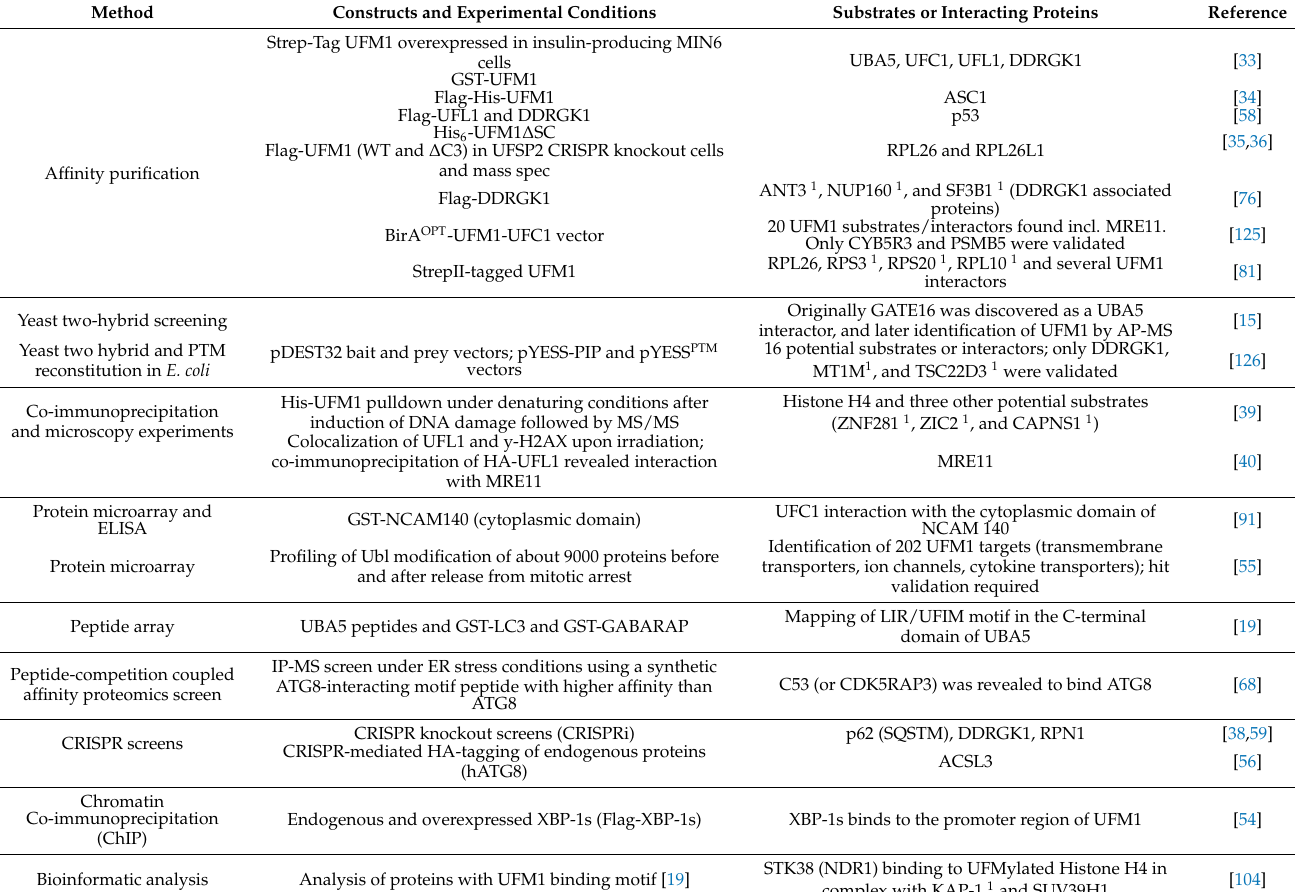
Table 1. Overview of methods and conditions used to identify UFM1 substrates and interacting